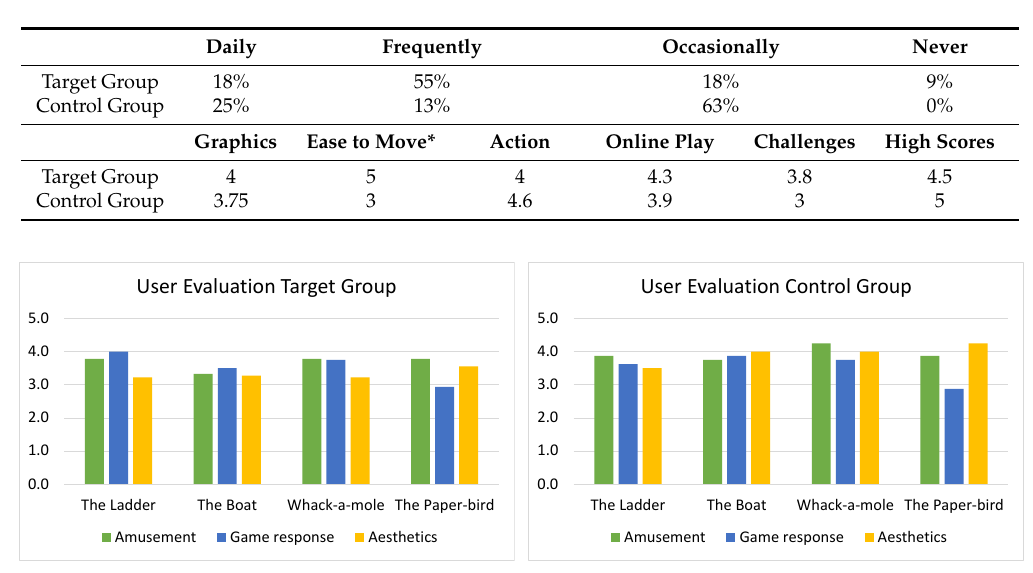
Table 3. Outcome of the Survey, Part 1—General Evaluation of Video Games. The question “ease to move” referred to the corporal movements to be made with or without remote controls.